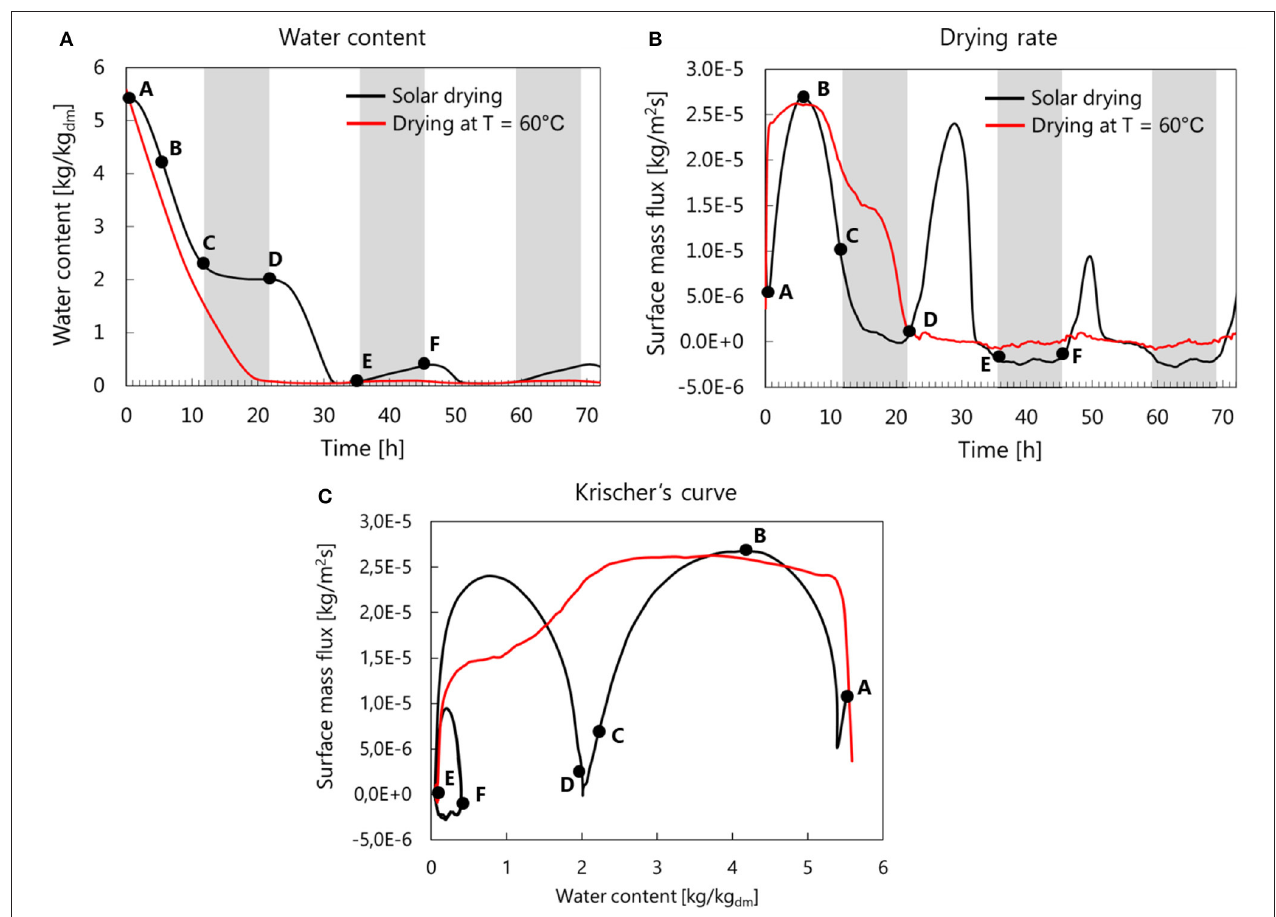
FIGURE 7 | Comparison of (A) water content, (B) drying rate, and (C) Kircher’s curve during solar drying and drying at a constant temperature of 60 ◦ C. Point A represents the initial condition. The gray zones indicate the night